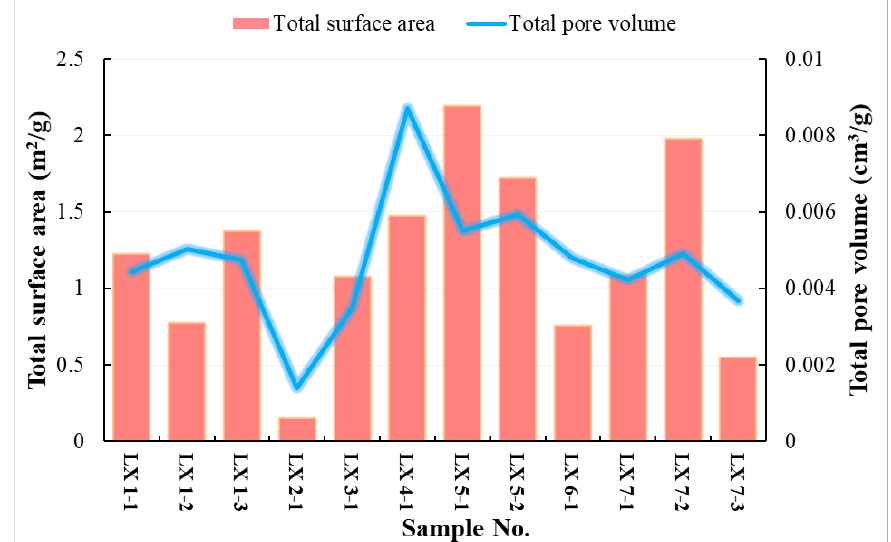
Figure 10. The total surface area and total pore volume of the shales.